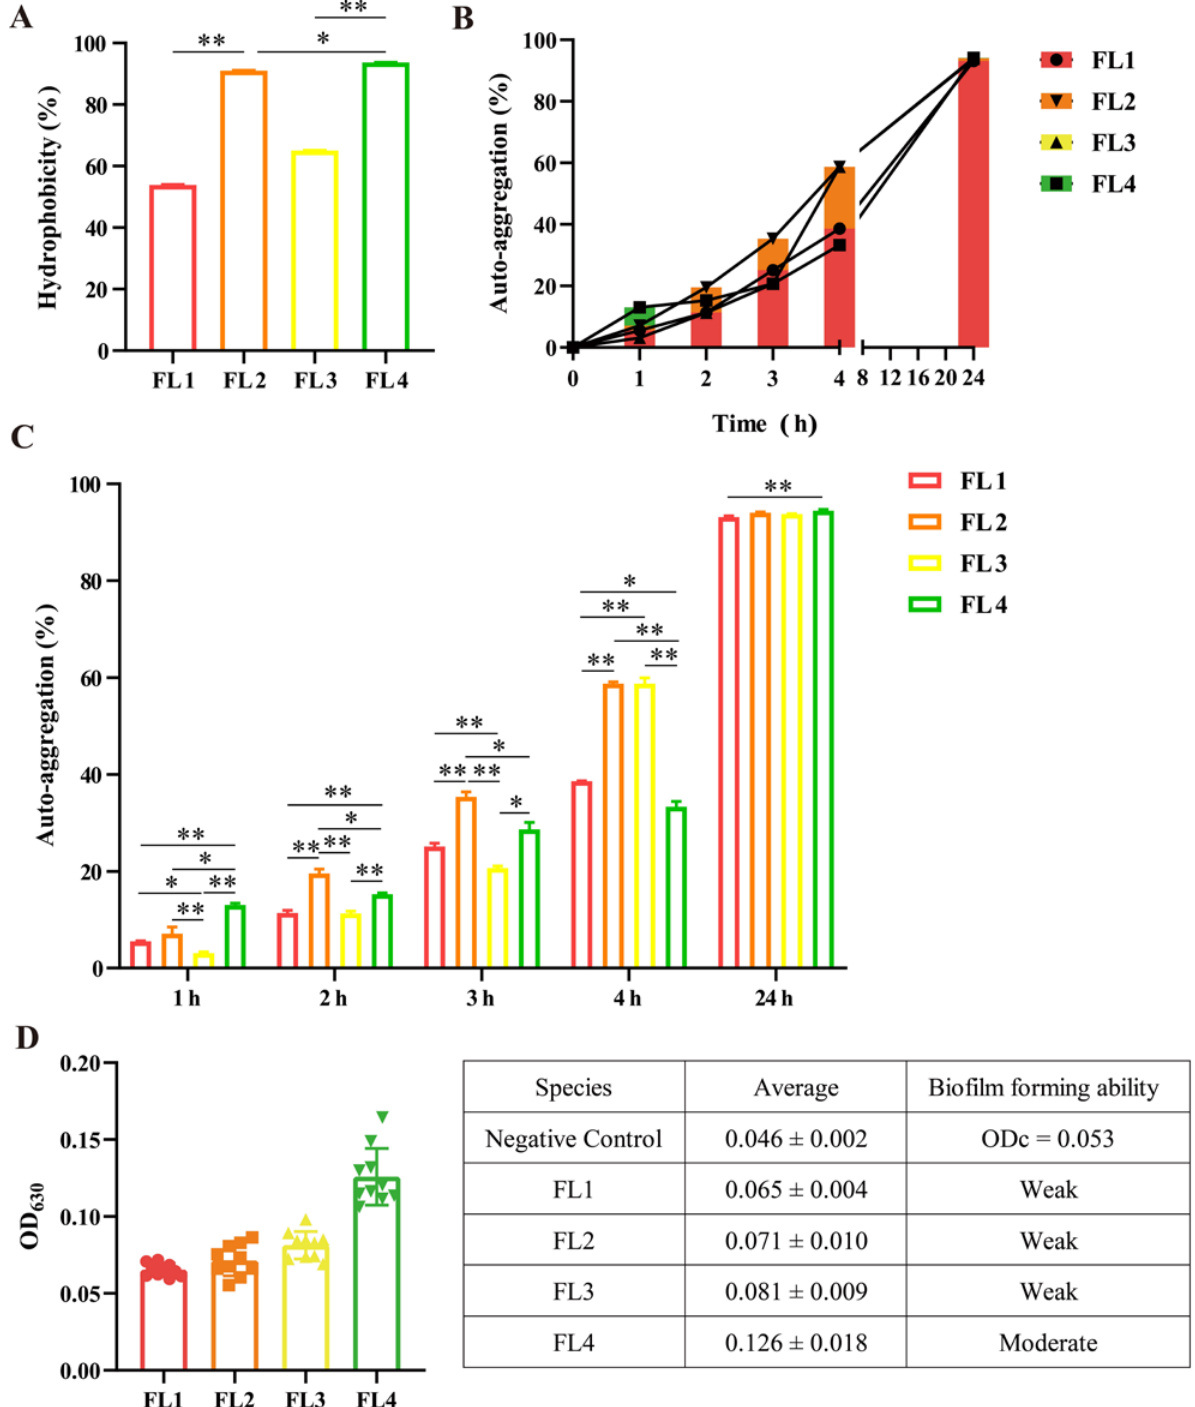
Figure 2. The adhesion abilities of four L. fermentum strains. ( A ) The cell surface hydrophobicity of isolated strains. ( B ) The trend graph of auto-aggregation ability by time. ( C ) Comparison of auto- aggregation of four L. fermentum strains at different times (1, 2, 3, 4 and 24 h). ( D ) The quantitative analysis of biofilm-forming capacity. Quantitative detection of biofilms: ODc = Negative Control (average) + 3 × SD. A < ODc, do not have the ability to form biofilms; ODc < A ≤ 2ODc, weak biofilm-forming ability; 2ODc < A ≤ 4ODc, moderate biofilm-forming ability; A ≥ 4ODc, strong biofilm-forming ability. Data were expressed as the mean ± SD (n = 10). * p < 0.05, ** p <